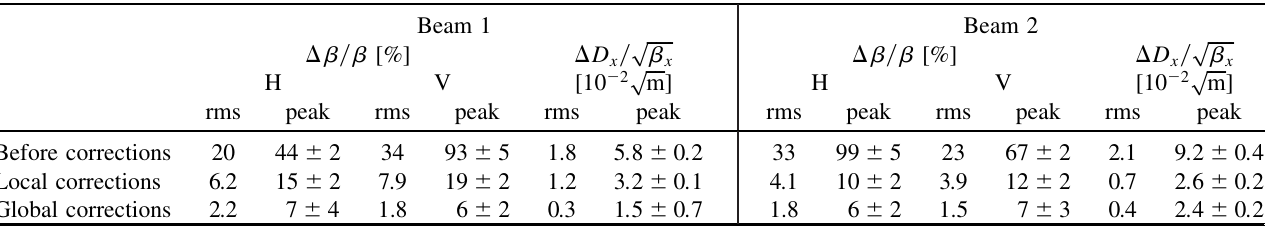
TABLE III. rms and peak (cid:1) - and D x = corrections.